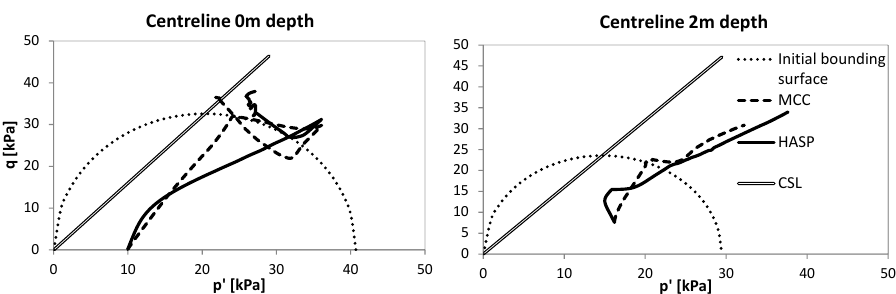
Figure 10. Effective stress paths for HASP and MCC models for center line at 0 and 2 m depth for Embankment A.